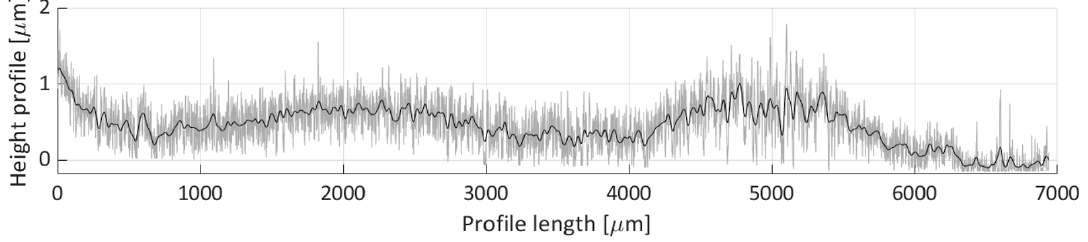
Figure 19. Height profile for the V1 line.